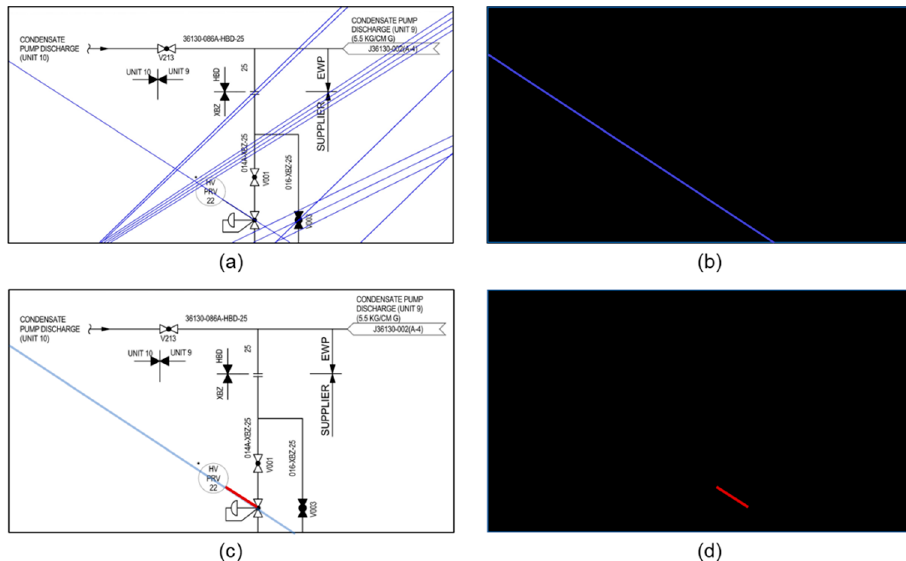
Figure 12. The process to recognize continuous diagonal lines. ( a ) Construct a diagonal candidate set using the Hough transform. ( b ) Draw a continuous diagonal line on the empty image. ( c ) Find a diagonal line from the candidate set that overlaps for a diagonal line of the diagrams. ( d ) Find the start and end points of the detected diagonal line.